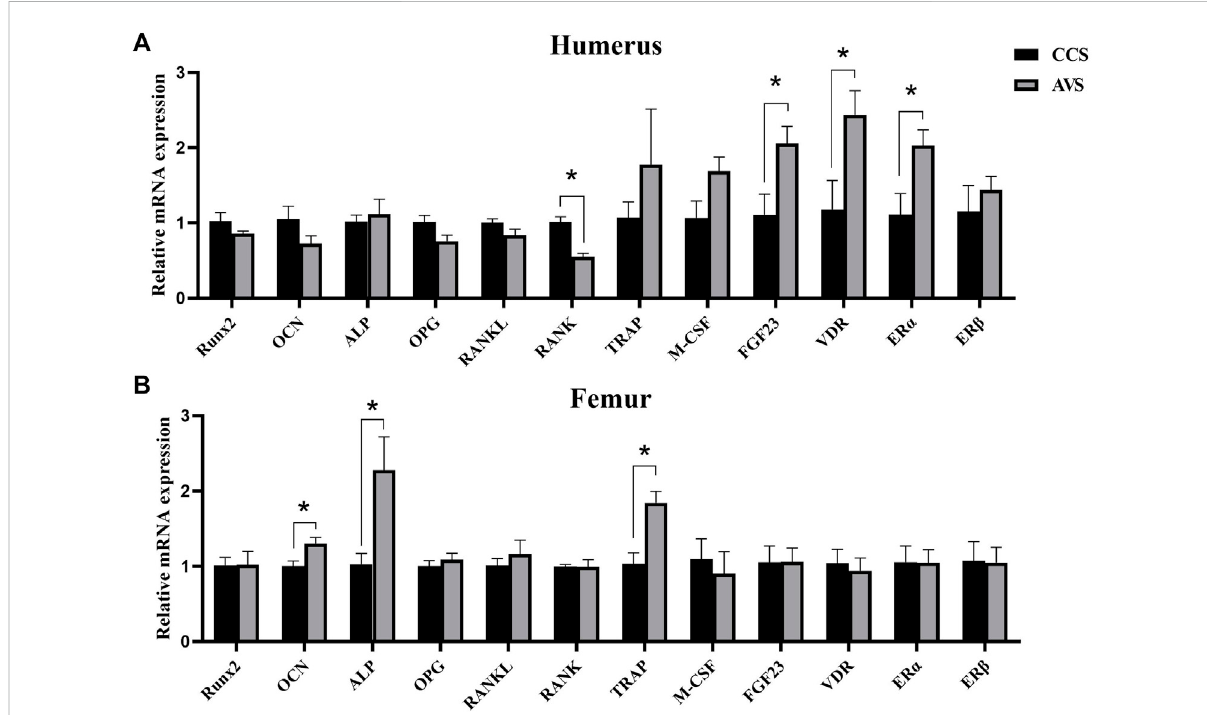
FIGURE 5 Effect of rearing systems on quanti fi cation of bone remodeling-related mRNA in bone of aged laying hens (95 weeks of age) (n = 6). (A) In the humerus, (B) in the femur. CCS, conventional caging system; AVS, aviary system. Runx2, runt-related transcription factor 2; OCN, osteocalcin; ALP, alkalinephosphatase;OPG,osteoprotegerin;RANKL,receptoractivatorofnuclearfactor-kappaBligand;RANK,receptoractivatorofnuclearfactor- kappa B; TRAP, tartrate-resistant acid phosphatase; M-CSF, macrophage colony-stimulating factor; FGF23, fi broblast growth factor 23; VDR, vitamin D receptor; ER α , estrogen receptor alpha; ER β , estrogen receptor beta. Data represent means with standard error. * p < 0.05.